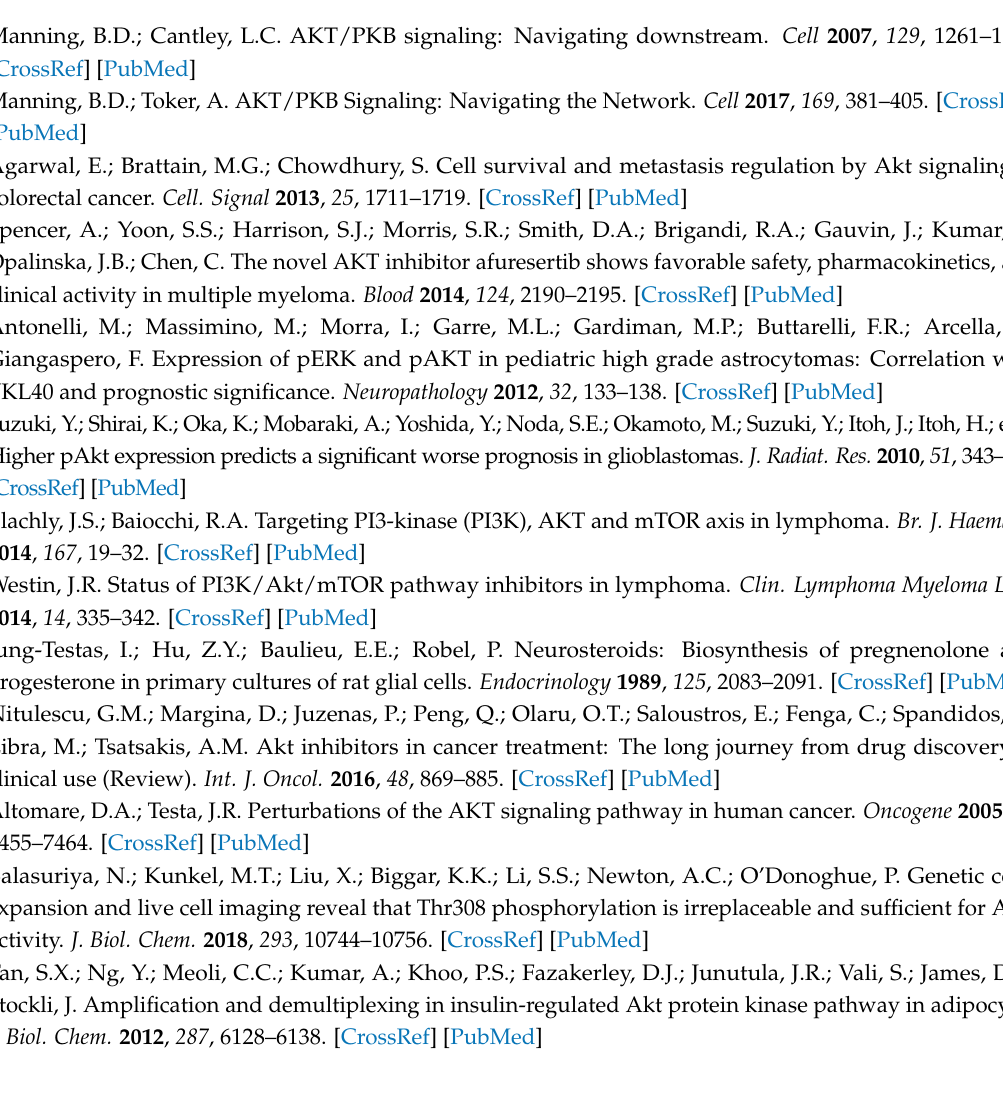
Supplementary Materials and Methods, Table S1: Plasmids used in this study, Figure S1: Mass spectra confirming Figure S4: Autoradiographs of Akt1 inhibitor assays with ppAkt1T308, S473, Figure S5: Autoradiographs of Akt1 inhibitor assays with pAkt1T308, Figure S6: Autoradiographs of Akt1 inhibitor assays with